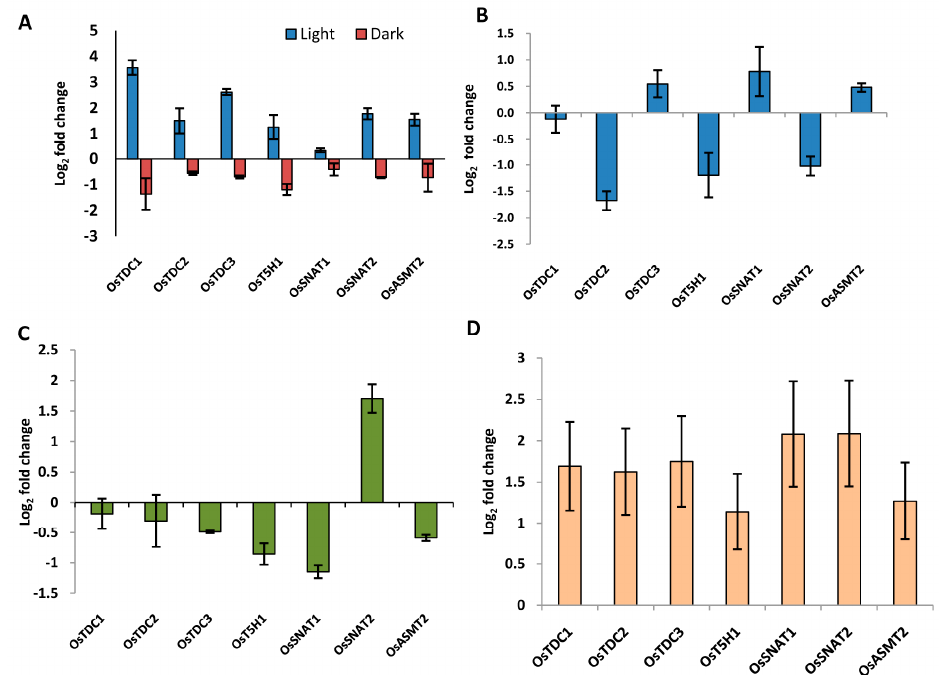
Figure 8. Expression analysis of genes encoding Ser and Mel biosynthetic enzymes in rice in response to light/dark and abiotic stress treatments by qRT-PCR. Expression profiling of genes encoding Ser and Mel biosynthetic enzymes in 8-day-old rice seedlings exposed to ( A ) light (100 µ mol/m 2 /s)/dark conditions, ( B ) salinity (200 mM NaCl), ( C ) heat (42 ◦ C) for 6h and ( D ) drought (water withheld) for 24 h. Logarithmic changes in expression levels have been calculated with respect to the untreated control. Normalization was carried out with respect to the housekeeping gene, elongation factor 1 alpha (eEf-1 α ).